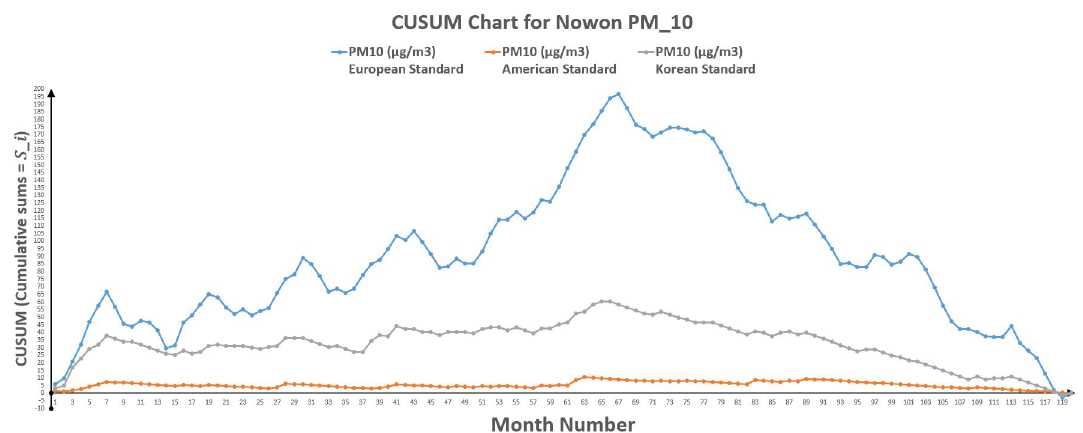
Figure 5. CUSUM chart for Nowon PM 10 .